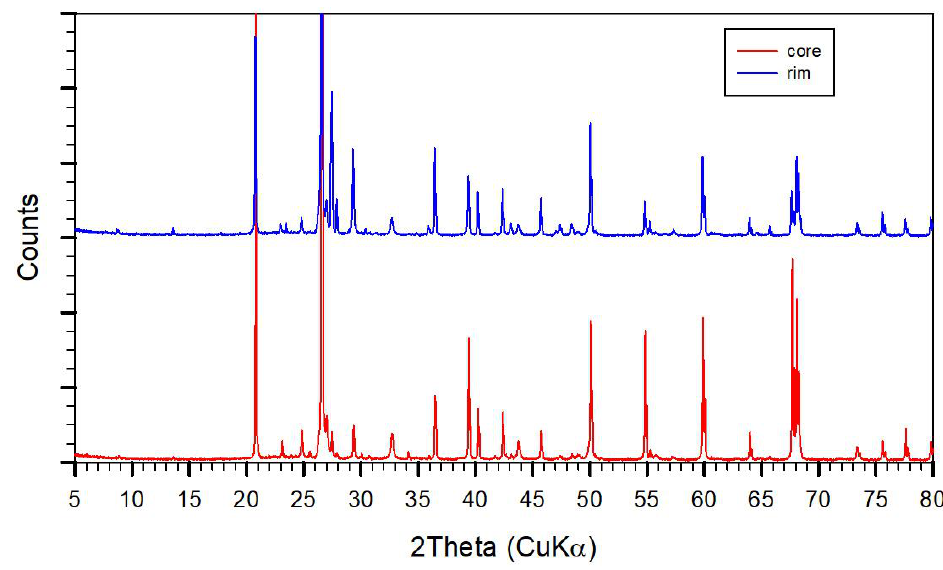
Figure 5. XRD-diagrams of a 68 years old lime sand brick probed at the core and rim.